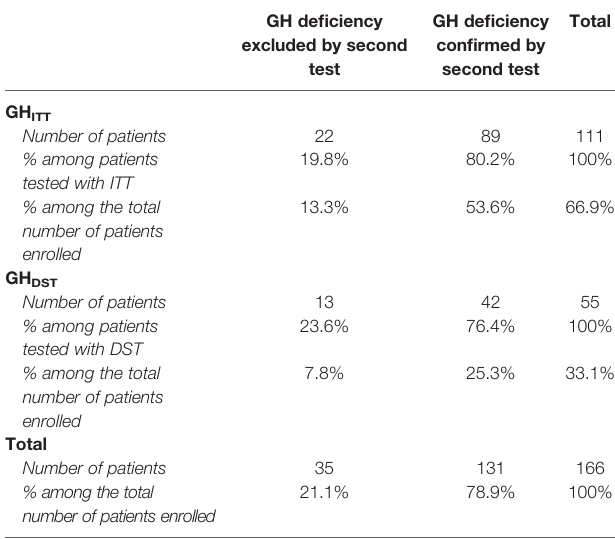
TABLE 2 | Distribution of patients enrolled according to the results of ITT and DST test: GH de fi ciency con fi rmed if GH peak achieved after ITT or DST < 8 ng/ ml. GH excluded if GH peak ≥ 8 ng/ml.